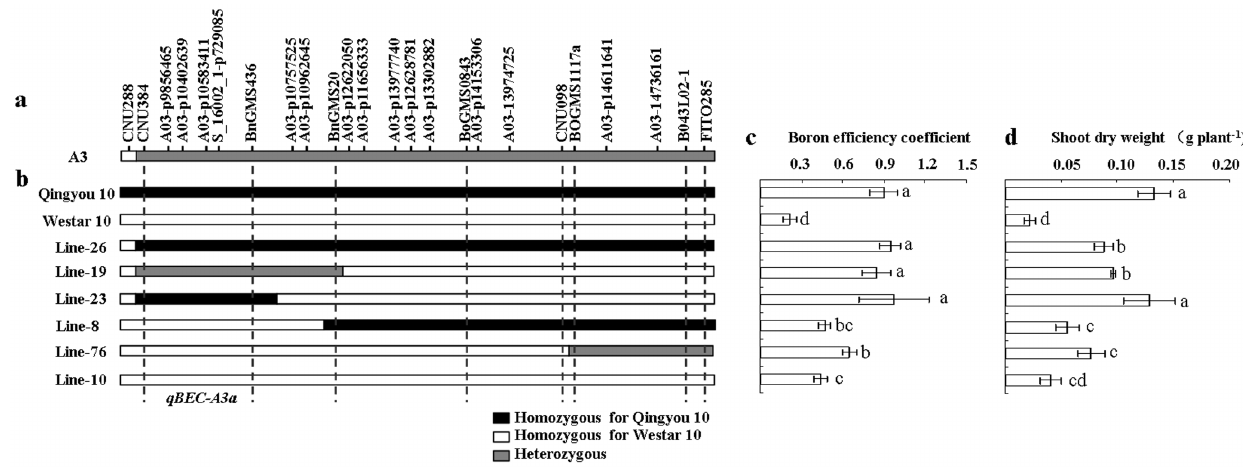
Figure 3. Schematic chromosomal fragments of substitution lines. a The region of qBEC-A3a in the A3 linkage group based on the QW DH population. b Substitution lines screened from the BC 4 F 2 population using eight SSR markers. The black bar represents the Qingyou 10 allele, the white bar represents the Westar 10 allele, and the grey bar represents the heterozygous genotype. c Boron efficiency coefficient (BEC) of each substitution line from the BC 4 F 2;3 family. d Shoot dry weight (SDW) values at low B for each substitution line from the BC 4 F 2;3